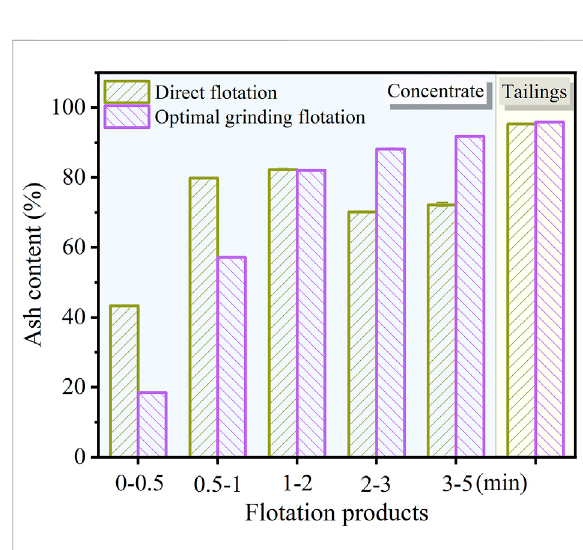
FIGURE 11 Comparison diagram of ash content of fl otation products under different